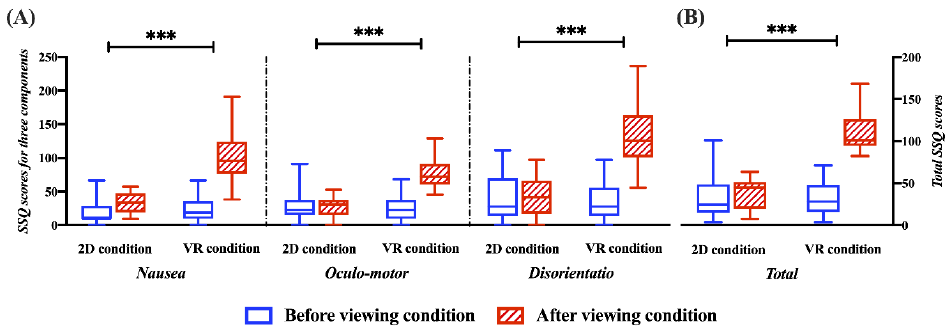
Figure 3. Representation of SSQ scores for MS between the 2D and VR conditions based on the ANCOVA test (*** p < 0.001). ( A ) SSQ items of nausea, oculomotor responses, and disorientation. ( B ) Total SSQ score.